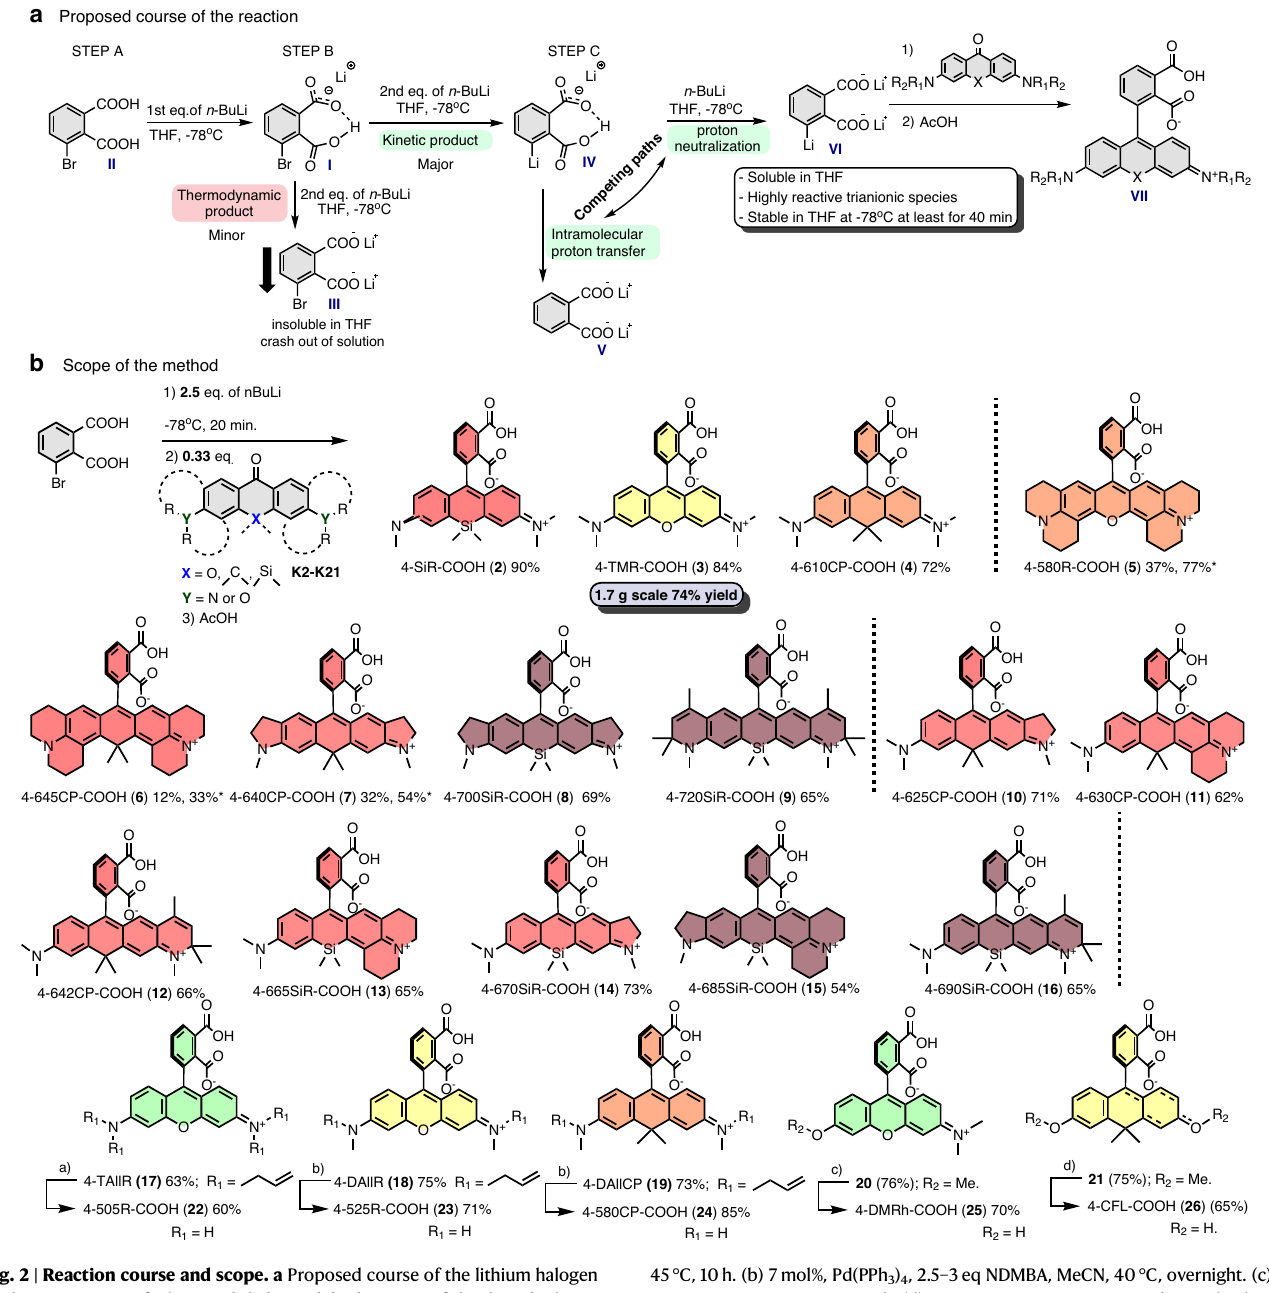
Fig. 2 | Reaction course and scope. a Proposed course of the lithium halogen exchange reaction of 3-bromophthalic acid. b The scope of the described 4-carboxyrhodaminesyntheticmethod(a)14mol%Pd(PPh 3 ) 4